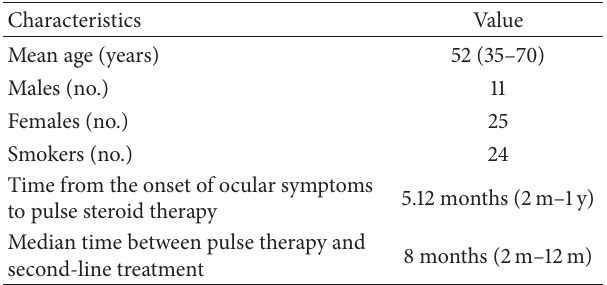
Table 1: Characteristics of enrolled patients ( 𝑛 = 36